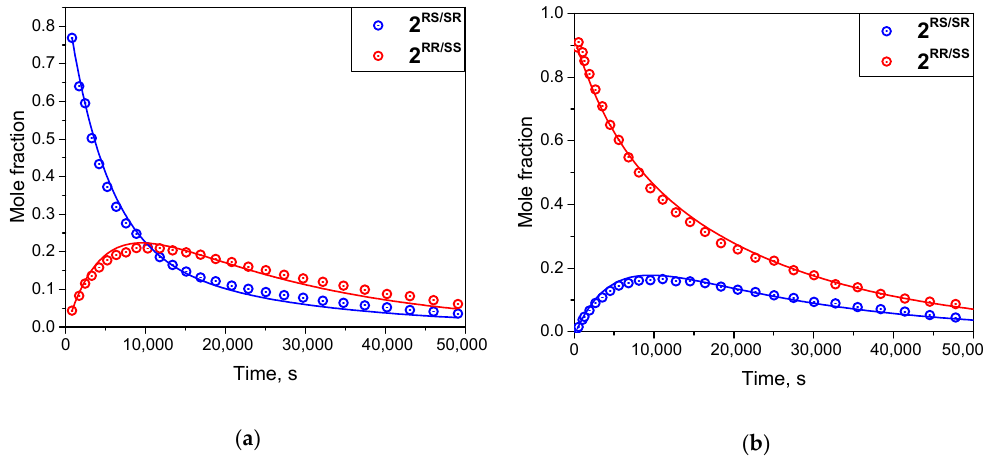
Figure 9. Kinetic curves for decomposition of 2 RS/SR and 2 RR/SS at 347 K in toluene-d 8 in the presence of spin trap BME. a ) Initial mole fraction of 2 RS/SR is equal to 1 while of 2 RR/SS is equal to zero. b ) Initial mole fraction of2 RR/SS is equal to 1 while of 2 RS/SR is equal to zero.